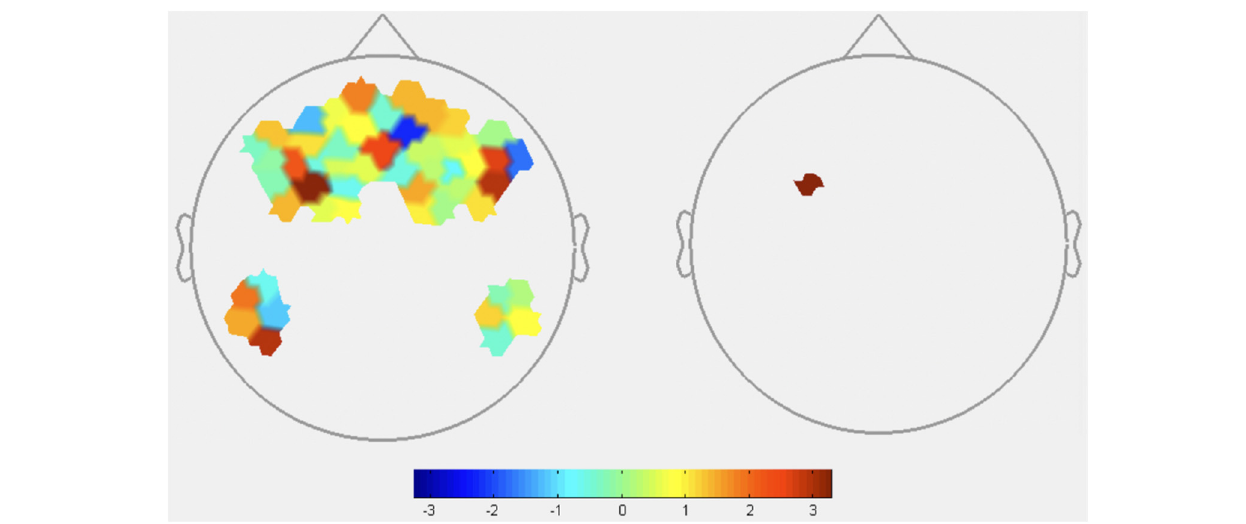
FIGURE 6 | HbO contrasts between low reliability and high reliability conditions: (T Low R Low + T High R Low )–(T Low R High +T High R High ). Left image displays all t -values, right image displays t-values that are statistically significant ( p < 0.05). Red coloration indicates more activation (higher HbO) during low reliability conditions compared to high reliability. Conversely, blue indicates more activation (lower HbO) during high reliability conditions.